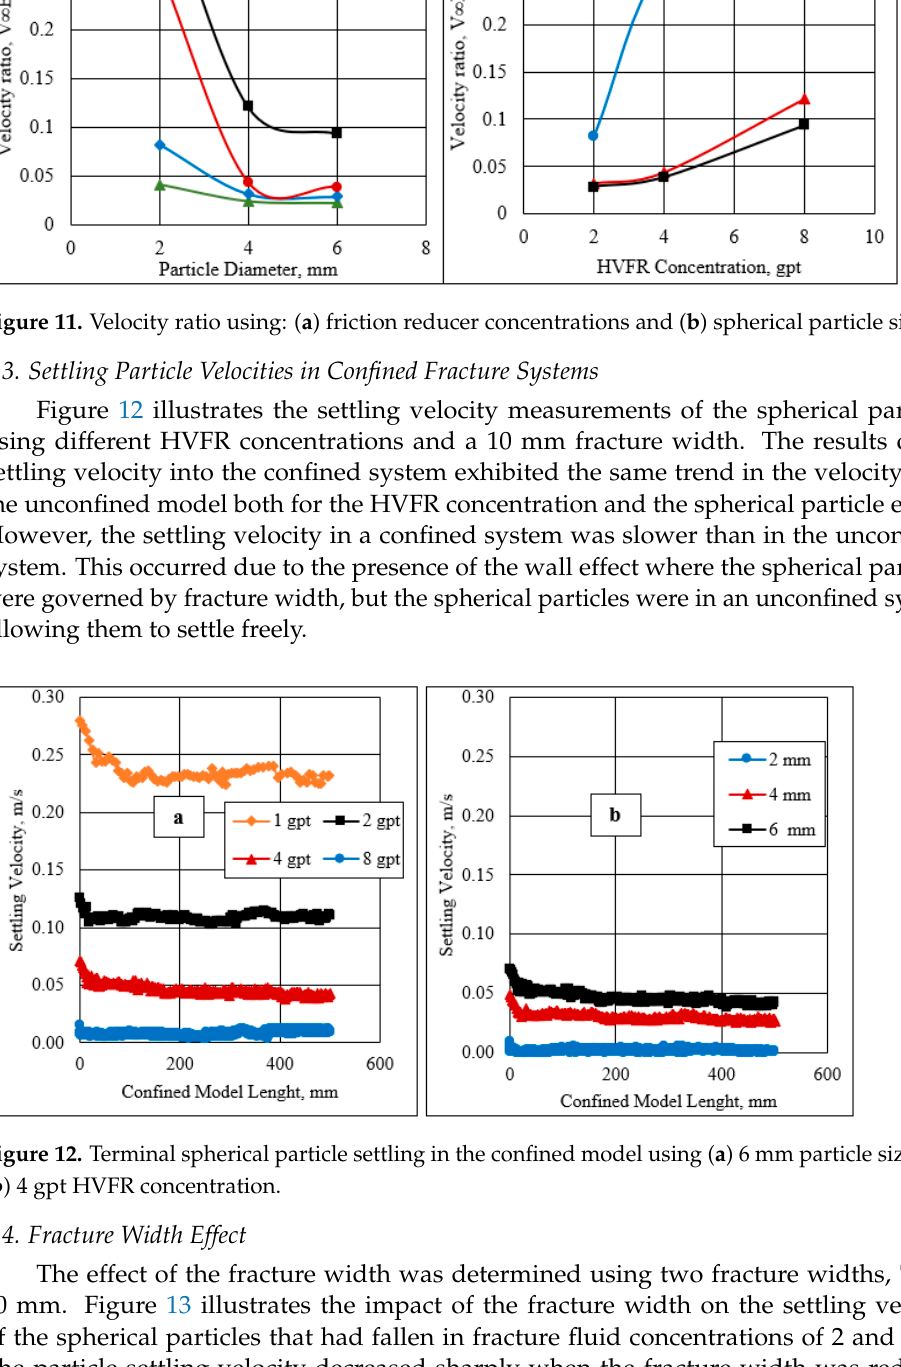
0.10.12 Figure 13. Terminal settling velocity of spherical particles using two fracture widths and two fric- tion reducer concentrations. Further analysis of the wall effect was conducted using the settling velocity results presented in Figures 9 and 12 for unconfined and confined fluids. The wall factor is a ratio of the settling velocity of the particle in a confined model to the settling velocity in an 00.020.040.06 0.08